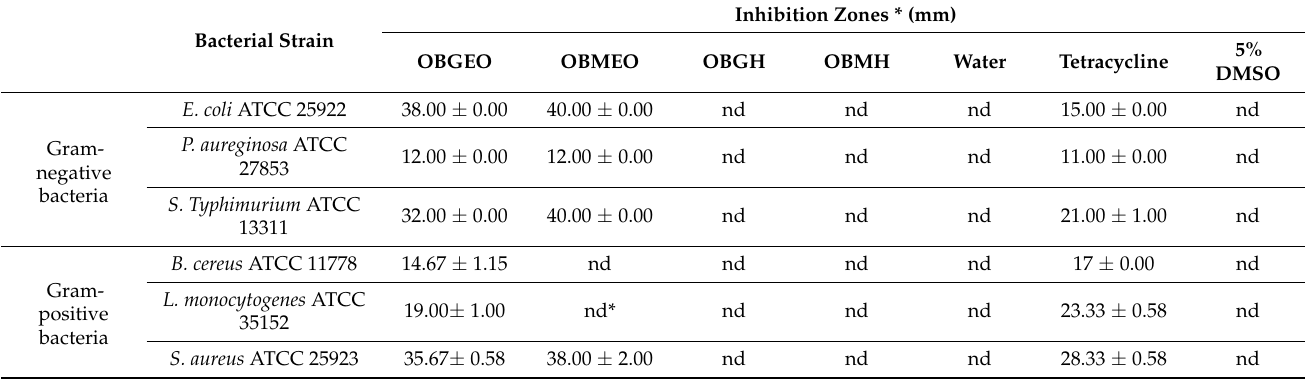
Table 3. Antimicrobial potential of O. basilicum essential oils and hydrolates.